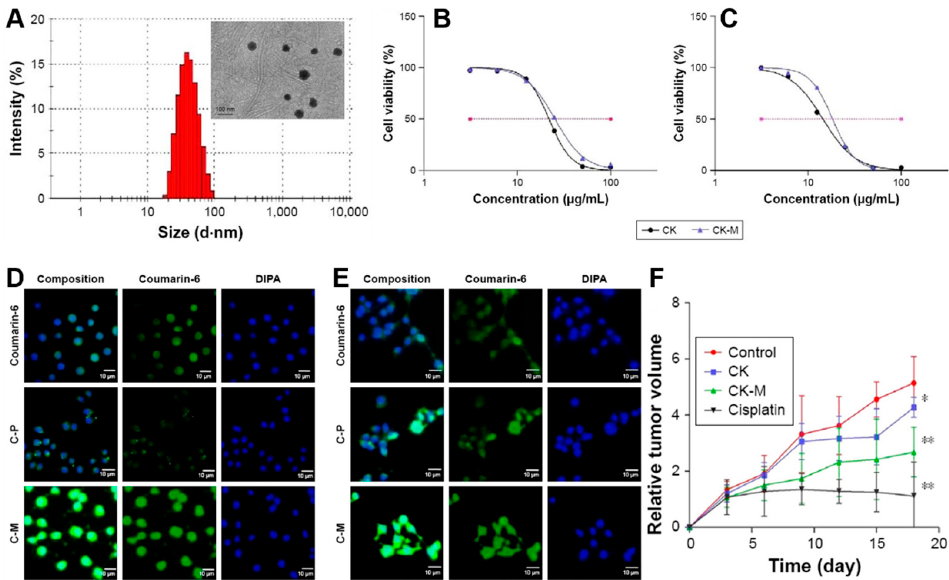
Figure 7. ( A ) Size distribution of the formulated CK-M and the spherical morphology of the CK-M micelle in TEM. ( B , C ) In vitro cytotoxicity of free ginsenoside CK and CK-M against A549 and PC-9 cell lines. ( D , E ) Cellular uptake of C-P (coumarin-6-loaded PEG-PCL micelles), C-M (coumarin-6-loaded mixed micelles) and coumarin-6 dyes under the fluorescent microscope in A549 cell line and in PC-9 cell line. ( F ) Relative tumor volume was calculated in vivo with cisplatin as positive control. Reprinted with permission from Ref. [125] . 2017, Dove Medical Press. (* p < 0.05, ** p < 0.01).